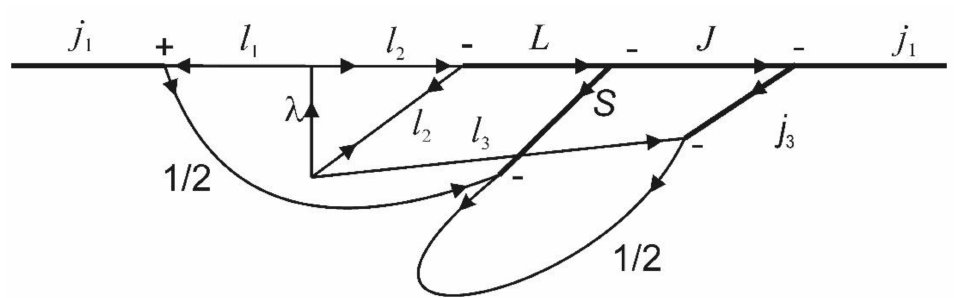
Figure 9. Momentum graph for the calculation of final state configuration interaction in intermediate coupling